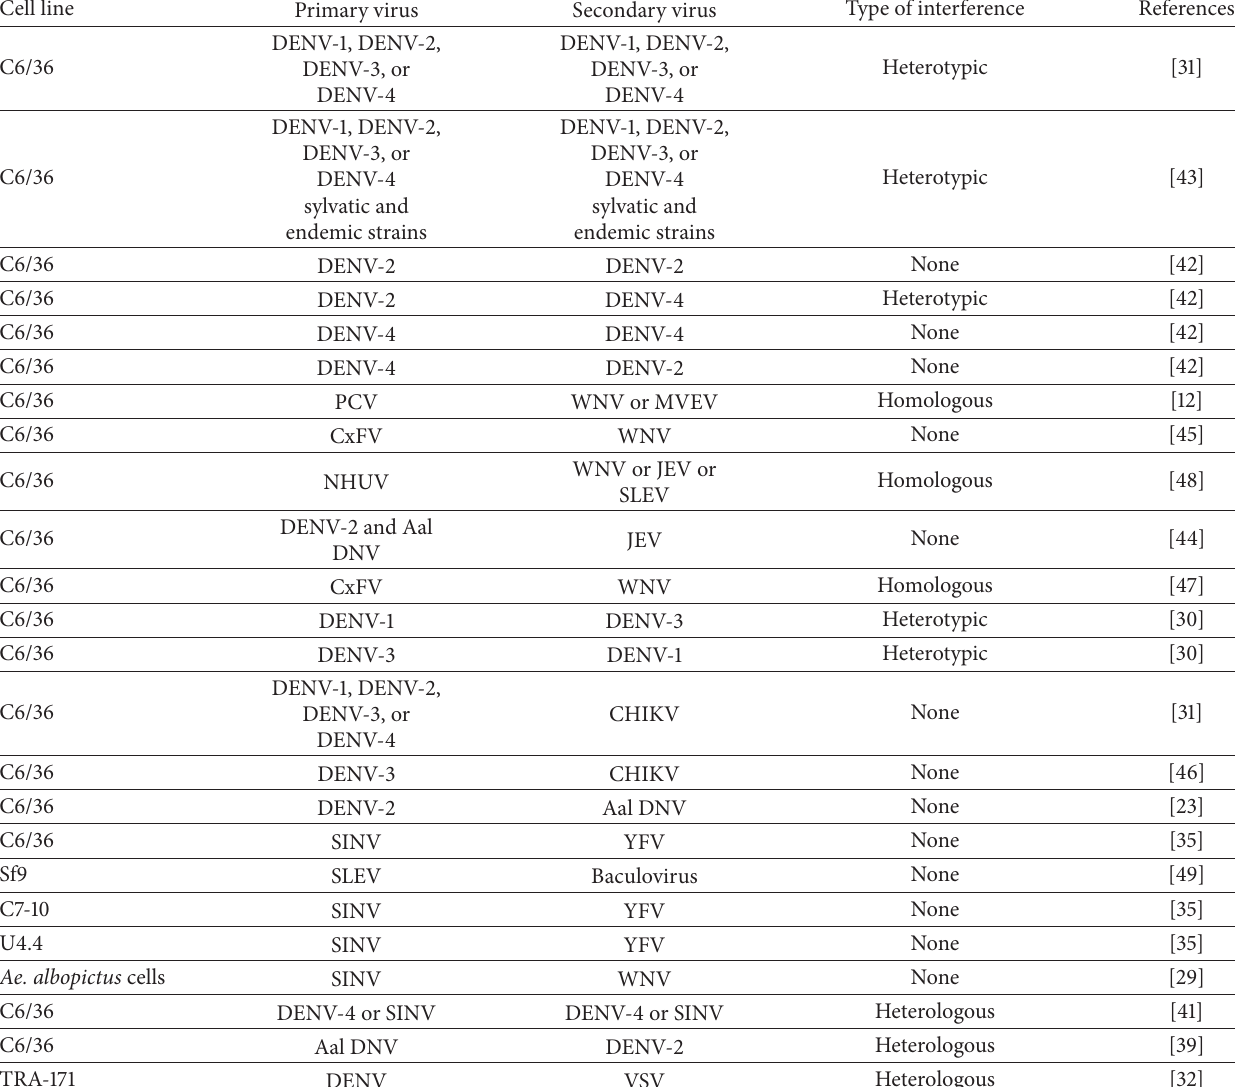
Table 2: Superinfections with flaviviruses in mosquito cell